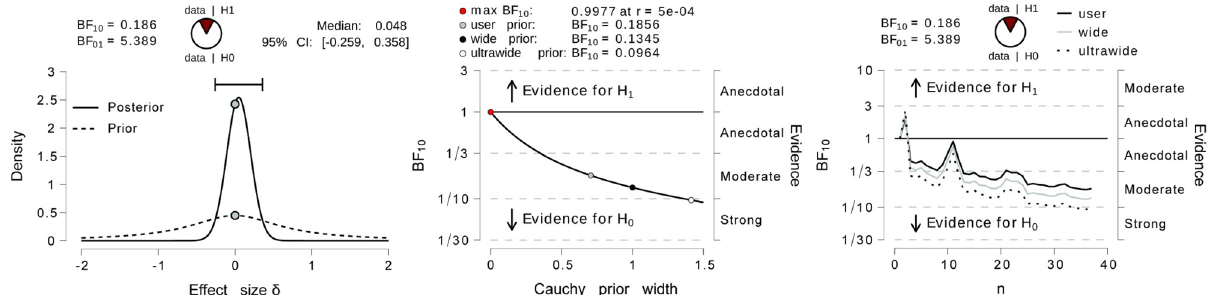
Figure 4. Results of the post-hoc Bayesian paired sample t-test between the two levels of sun manipulation. On the left, the effect size as a function of the prior and posterior density. In the middle BF 10 as a function of tested prior. On the right, accumulation of evidence towards H0 as a function of the number of samples